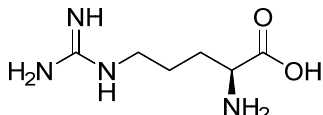
Figure 5. Structure of L -arginine.